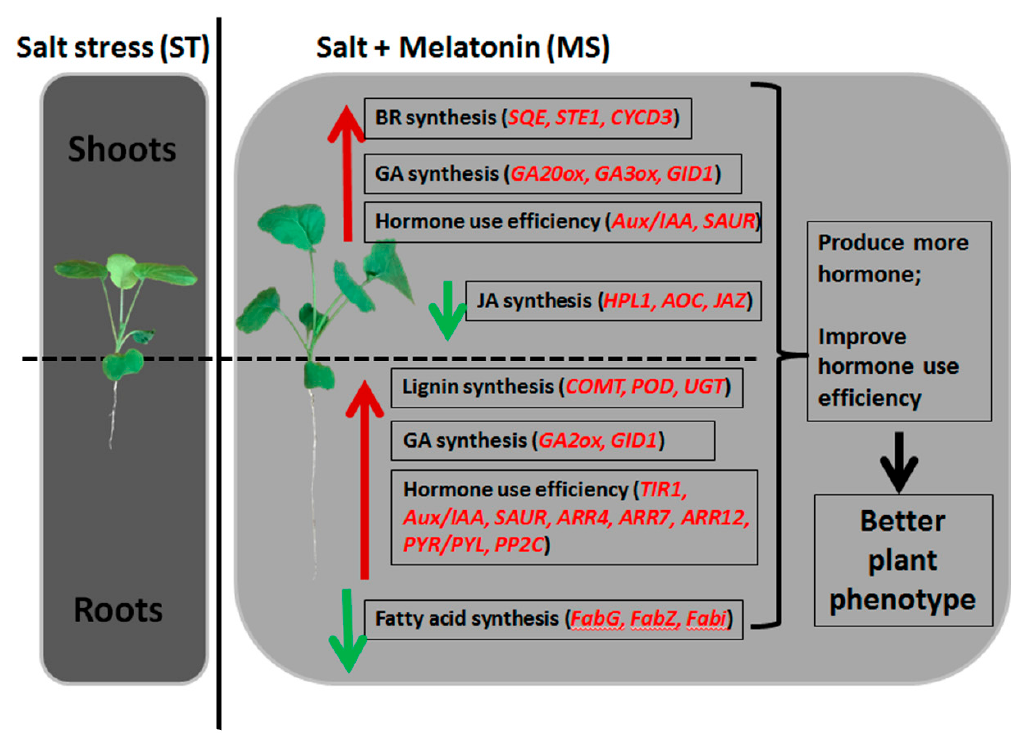
Figure 7. Proposed model for the function of melatonin in alleviating the harm from salt stress. The up-pointing red arrows mean that the candidate pathways are enhanced; the down-pointing green arrows mean that the candidate pathways are diminished. The main affected pathways were shown in the boxes. The vital genes affecting the corresponding pathways are shown in red italics within brackets. BR = brassinolides; GA = gibberellic acid; JA = jasmonic acid.